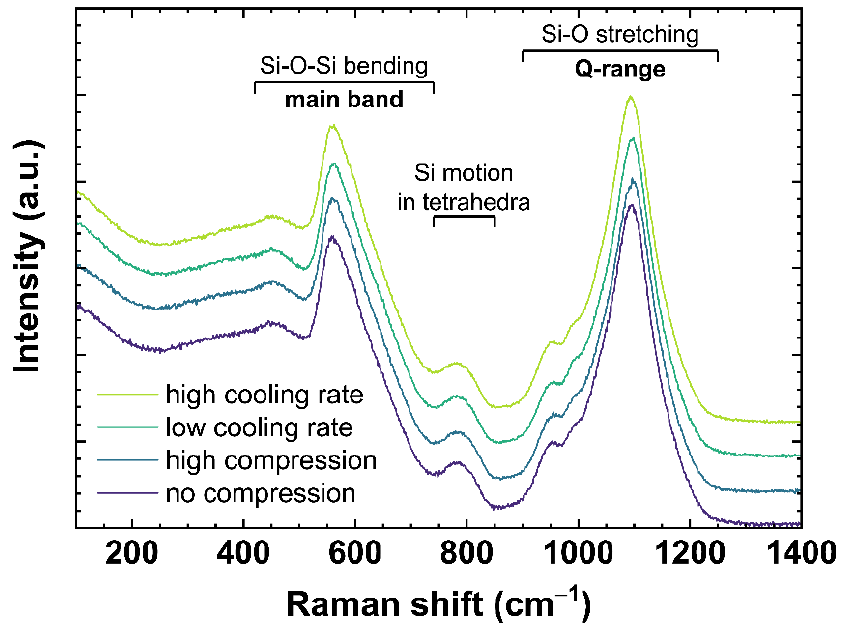
Figure 2. Raman spectra of OptiWhite q g 1 cooled with 6 × 10 − 4 K/min (low cooling rate) and 650 K/min (high cooling rate) as well as US_T g 1 under no uniaxial compression (0 GPa) and high uniaxial compression ( − 0.85 GPa). Assignments of the observed vibrational bands are given in Section 2.4.1.